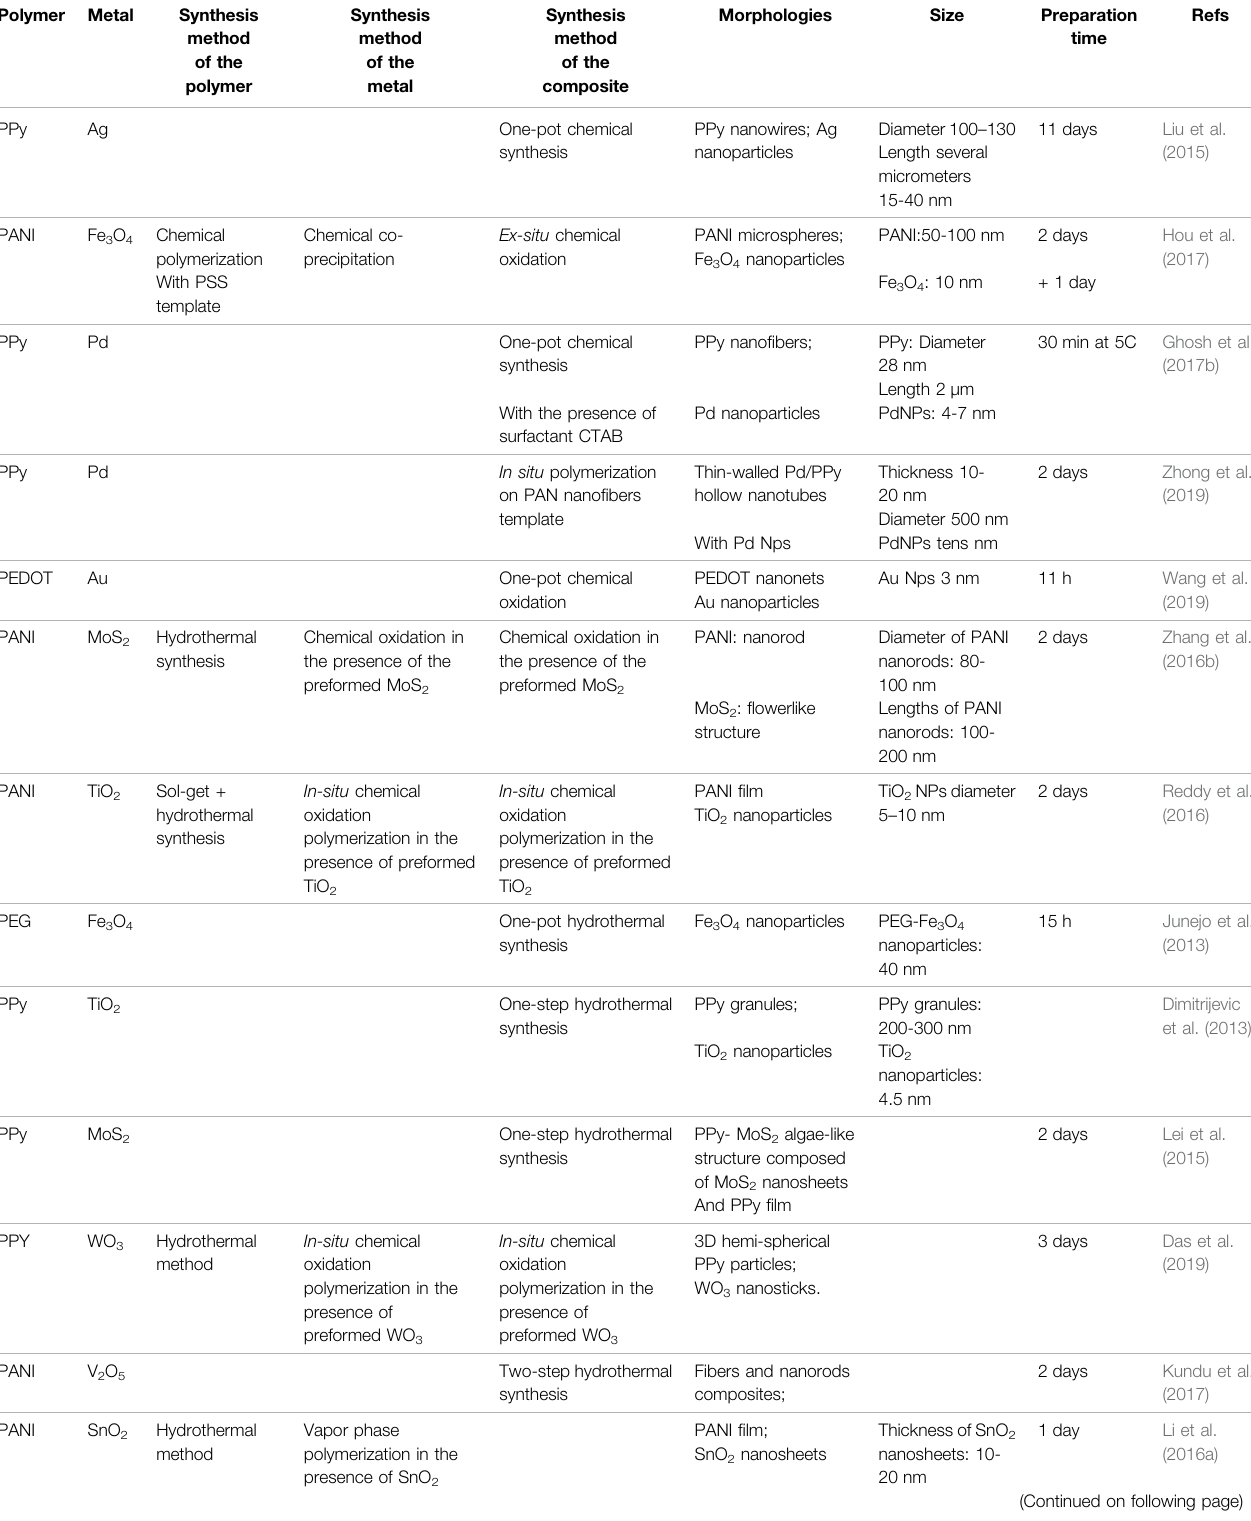
TABLE 1 | Comparison of morphological structure and synthesis techniques of monometallic-based conducting polymers